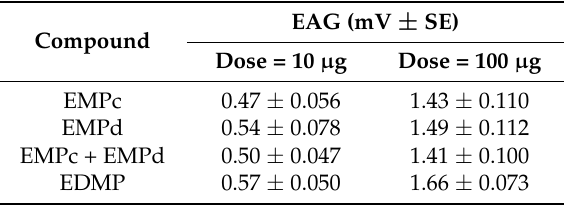
Table 2. Electroantennogram (EAG) response of S. invicta workers to HPLC-purified EMPc, EMPd, and their mixture.